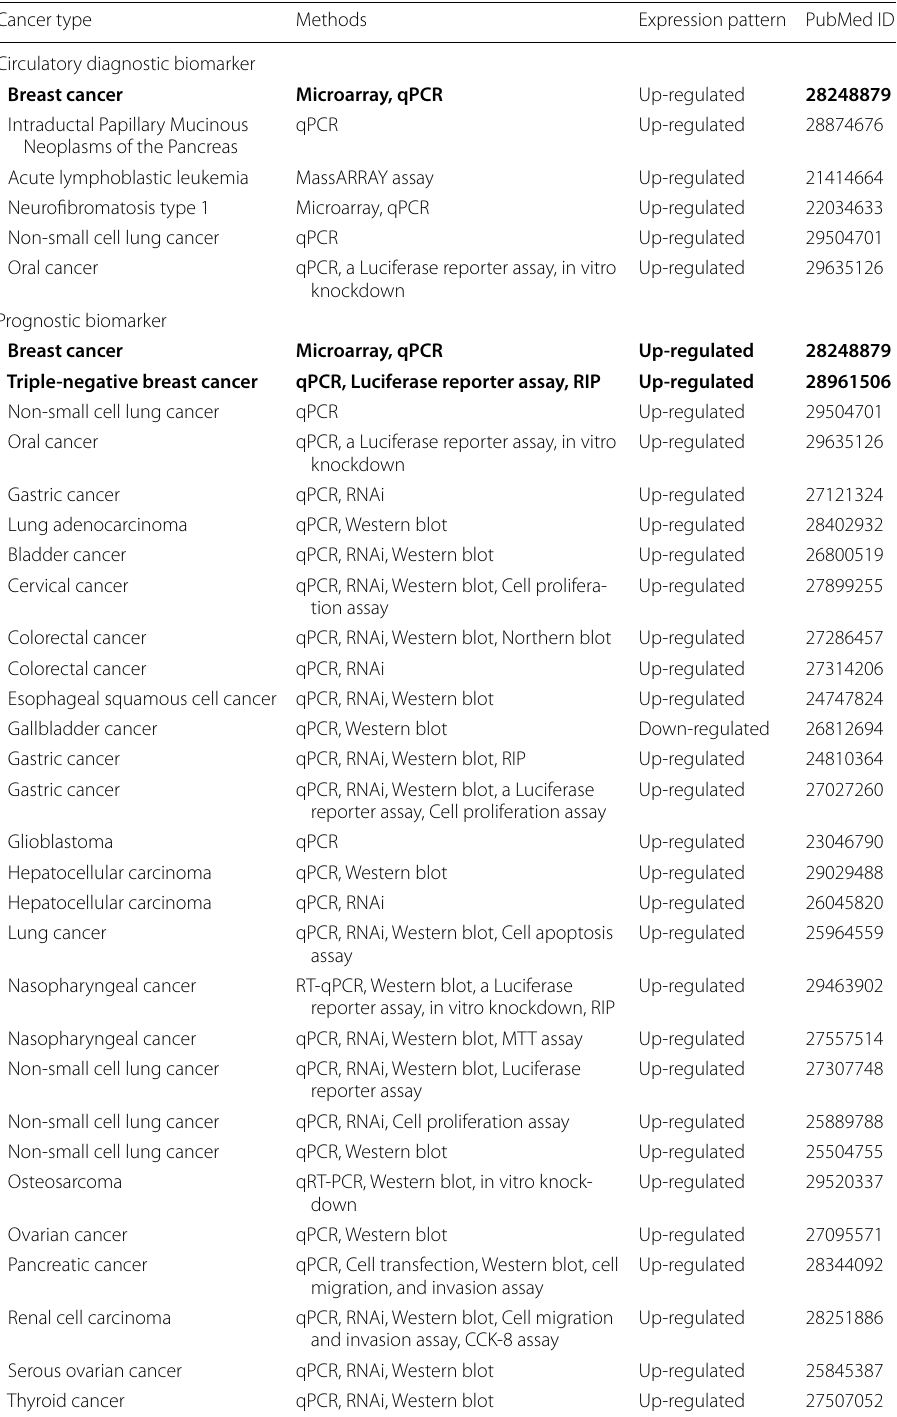
Table 3 CDKN2AB-AS1 quantification in cancer patients as a diagnostic and prognostic biomarker. Data source : Lnc2Cancer version 2.0